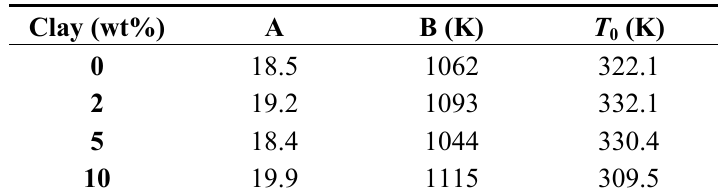
Table 4. Dependence of the VTF parameters on the clay content in nanocomposites cured with Lupasol.